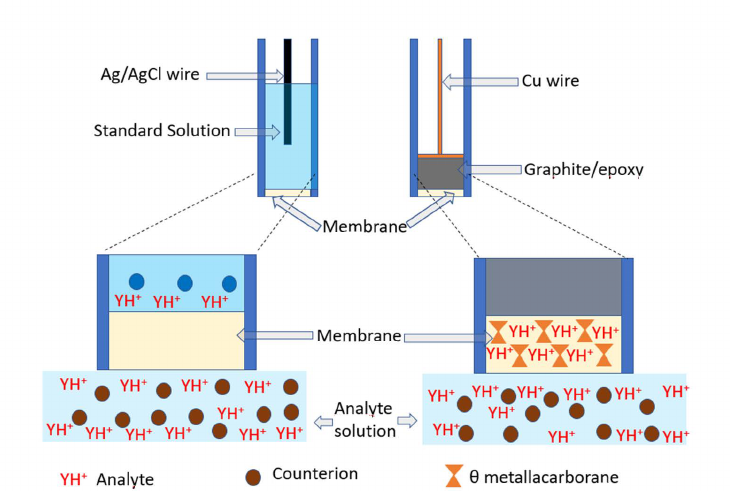
Figure 3. Schematic representation of conventional membrane liquid ISEs ( top left ) and membrane solid state ( top right ) with a magnification of their lower part displaying where the analytes are, and where the metallabis(dicarbollides)